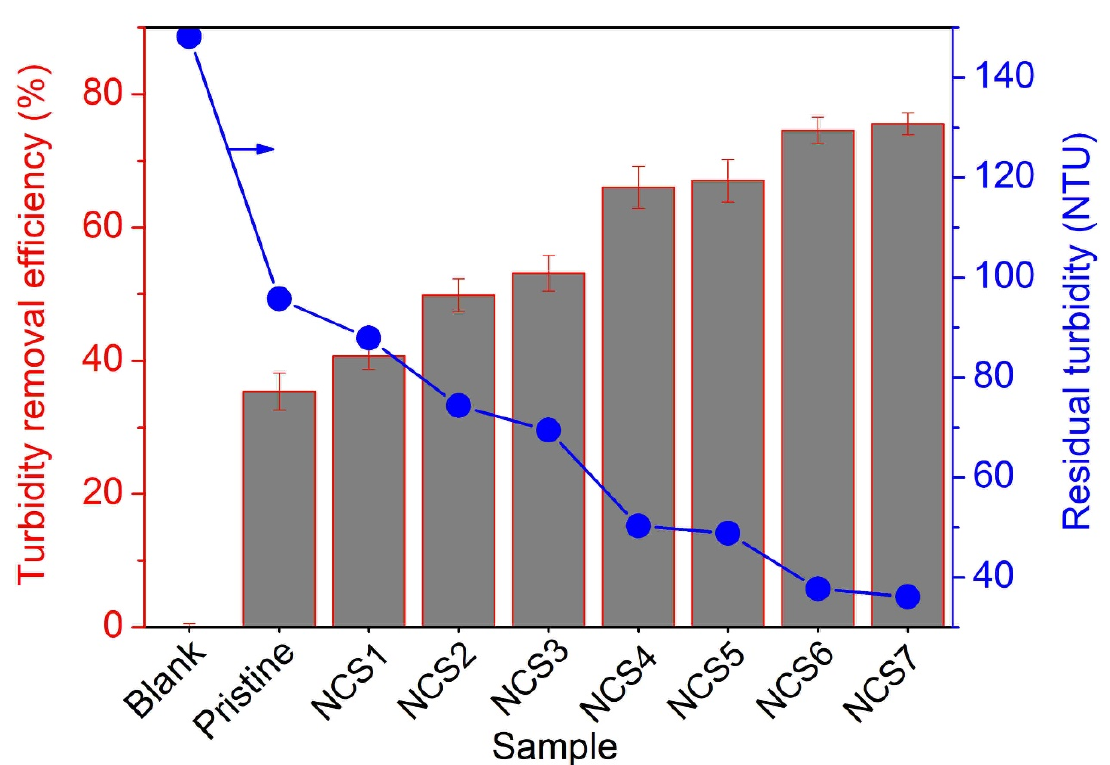
Figure 6. Turbidity removal performance of pristine and nanosized chitosan solids where the turbidity removal efficiency ( left ) and residual turbidity values ( right ) are presented.